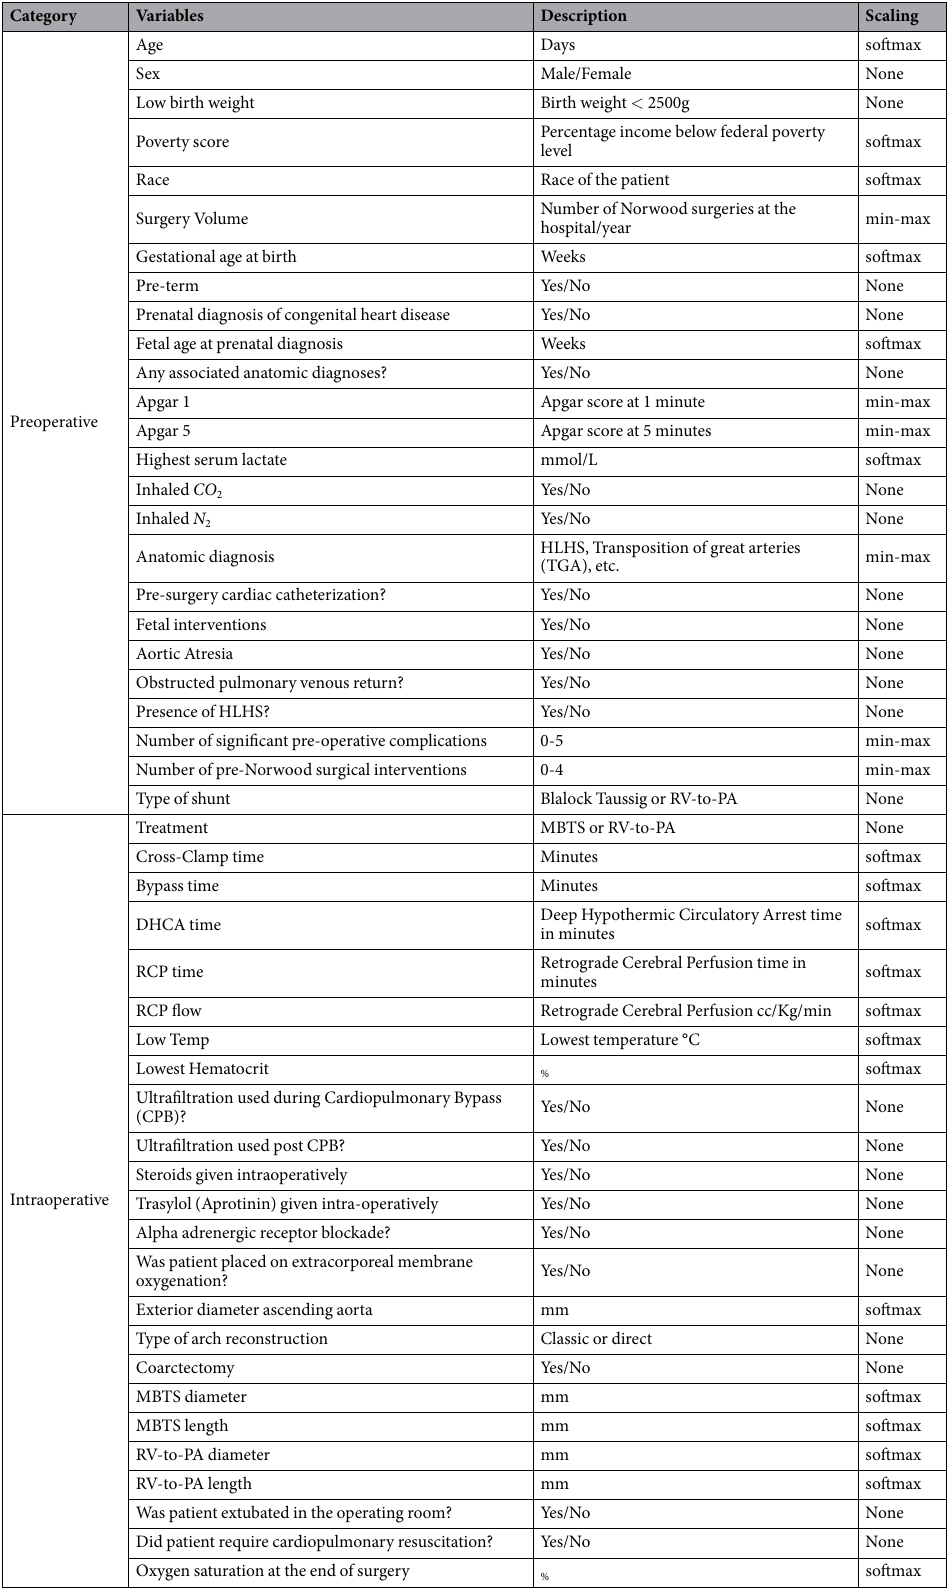
Table 1. Selected variables from the dataset for machine learning modeling. Preoperative data was used for mortality prediction model, while a combination of both preoperative and intraoperative data was only used for prolonged LOS prediction. Scaling shows the methodology used to scale the